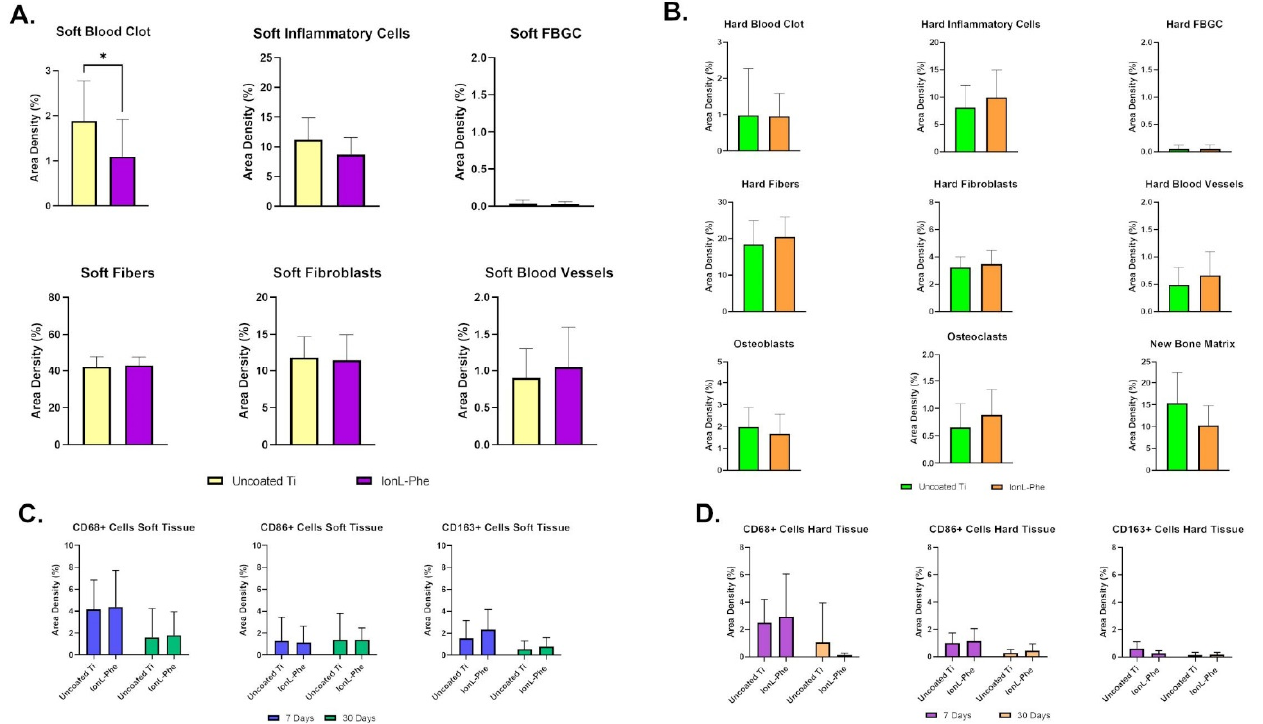
Figure 5. Histomorphometry of ( A ) soft tissue and ( B ) hard tissue healing parameters in YM group at 7 days. Morphometry of CD68, CD86, and CD163 positive cells ( C ) soft and ( D ) hard tissue of YM uncoated and IonL-Phe coated Ti at 7 days. ( n = 10). * Indicates statistical significance among groups ( p < 0.05).